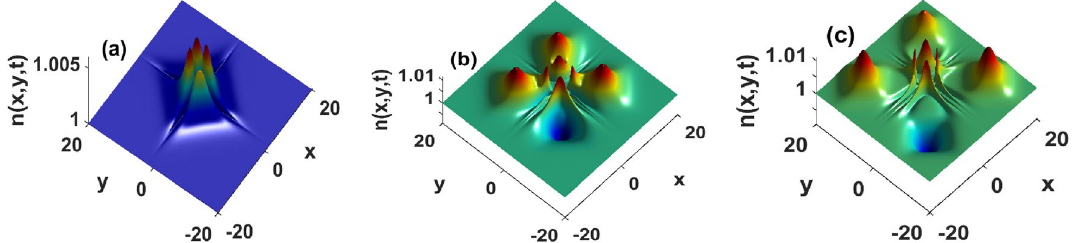
Figure 7. Diffusion initiates a fast scattering of initially localized bacterial density across the domain t = 0.1, and for D 2 = 1.62 . ( a ): α = 1 , ( b ) α = 20 , and ( c ) α = 50